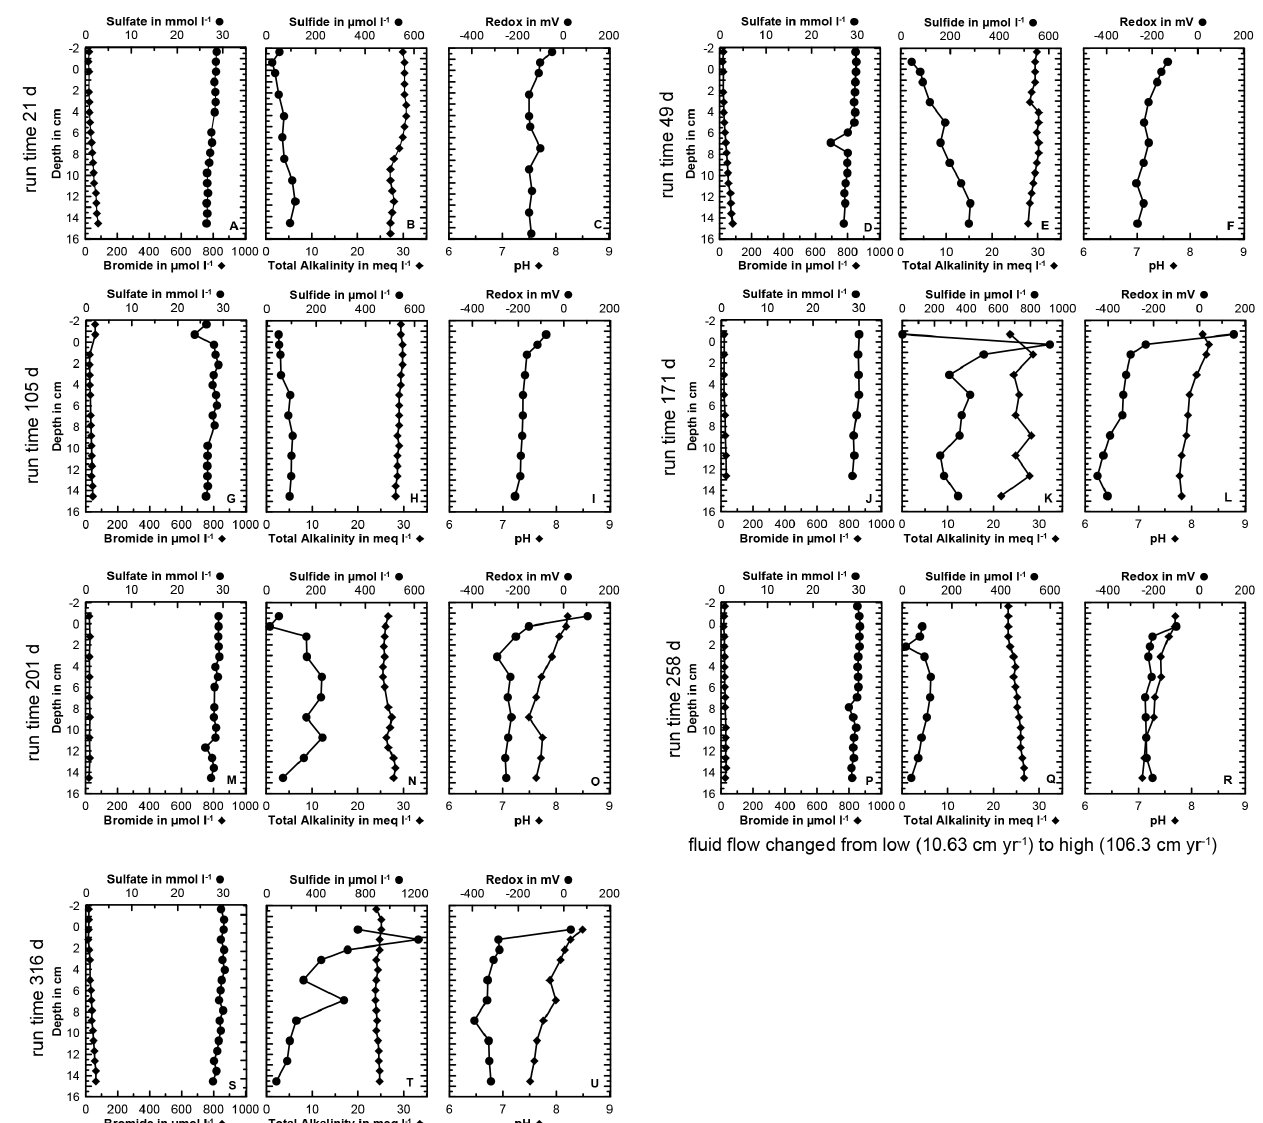
Figure 3. Sulfate and bromide concentrations (left panels), sulfide and total alkalinity concentrations (middle panels), and redox potential and pH (right panels) measured in the sediment of the low-flow regime core (LFC) from Quepos Slide after different days of runtime indicated on the left. All concentrations are presented as per liter of porewater. Please note the different scales for sulfide concentrations.